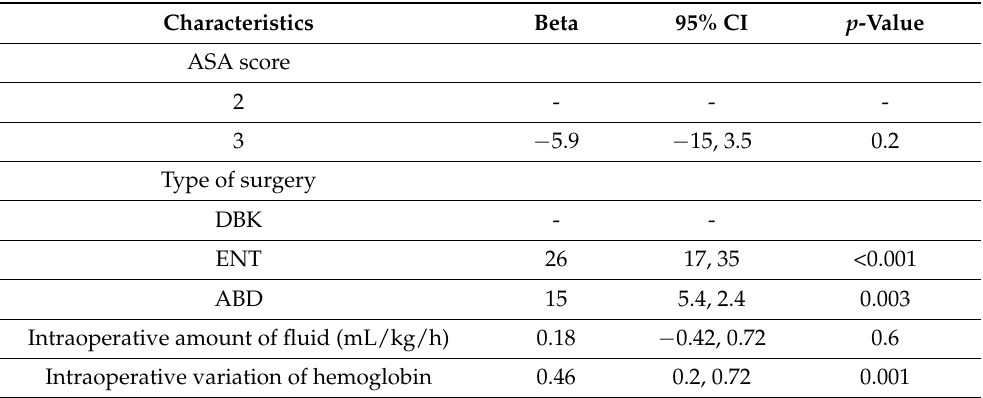
Table 3. Regression model for the maximum variation of albumin with regard to ASA score and DBK surgery.